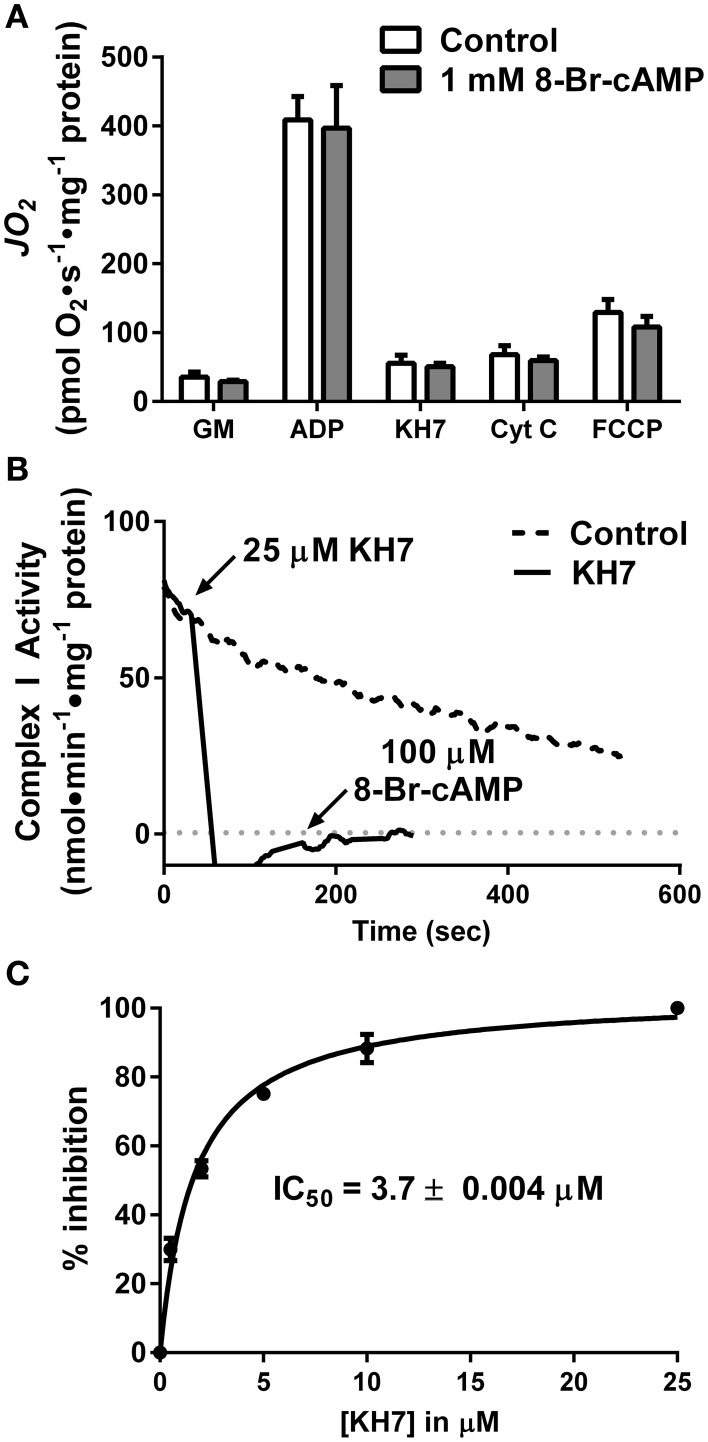
The soluble adenylyl cyclase inhibitor KH7 inhibits complex I activity independent of cAMP/PKA signaling. (A)
JO2 was measured during a step-wise titration protocol in isolated liver mitochondria in the absence (white bars) or presence (gray bars) of 1 mM 8Br-cAMP. Each sequential addition was made after reaching a steady-state rate of O2 flux. N = 4/condition. (B) Complex I activity was determined by the oxidation rate of NADH in fragments of isolated skeletal muscle mitochondria following no treatment (dashed line) or sequential addition of 25 μM KH7 and 100 μM 8Br-cAMP (solid line). (C) Dose-response inhibition curve generated for inhibition of complex I activity as a function of KH7 concentration. N = 3 separate observations.